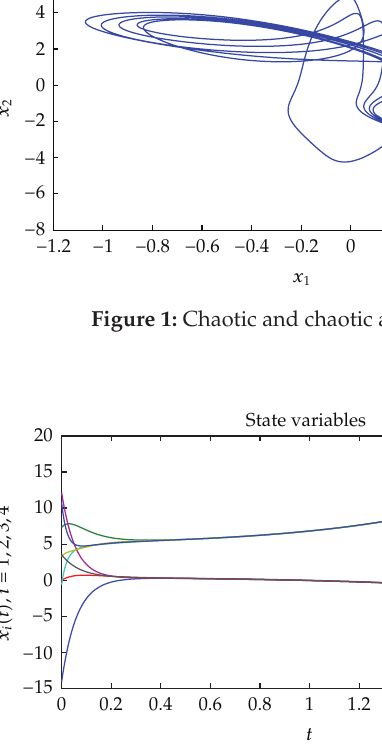
Figure 2: The state variables x i 1 (cid:7) t (cid:8) and x i 2 (cid:7) t (cid:8) without impulsive e ff